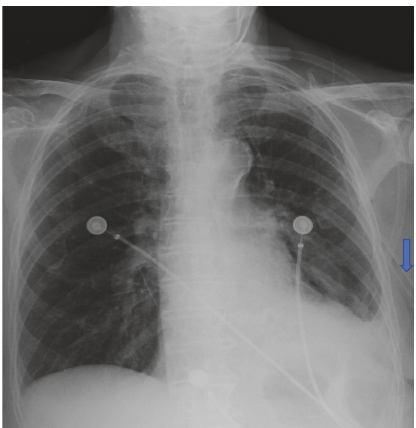
Figure 2: Postthoracostomy portable chest X-ray showing reex- panded left lung with residual atelectasis and or consolidation. The blue arrow points to the chest tube near the insertion